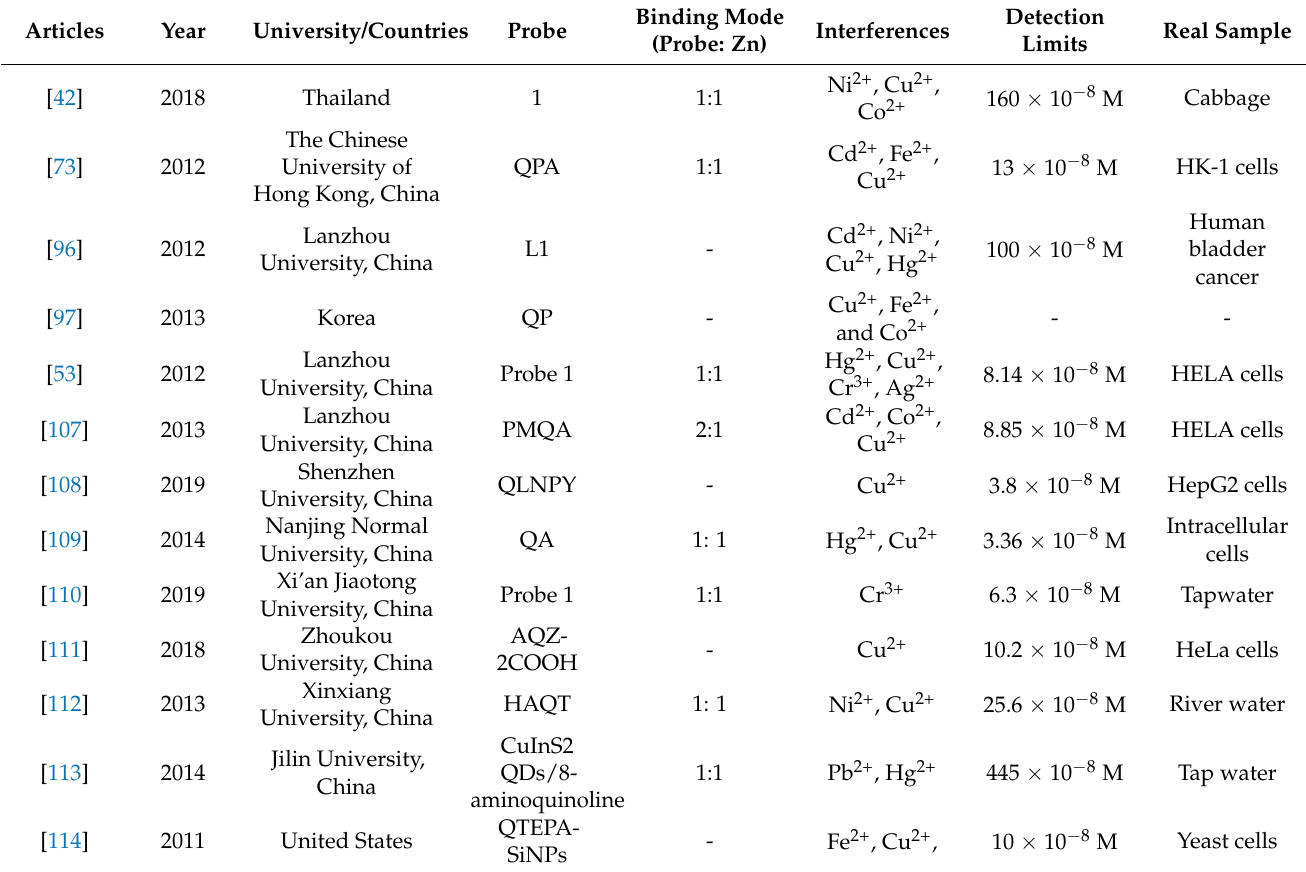
Table 2. The comparisons and assessments of collected studies that related to 8-amidoquinoline derivatives as fluorophore of zinc